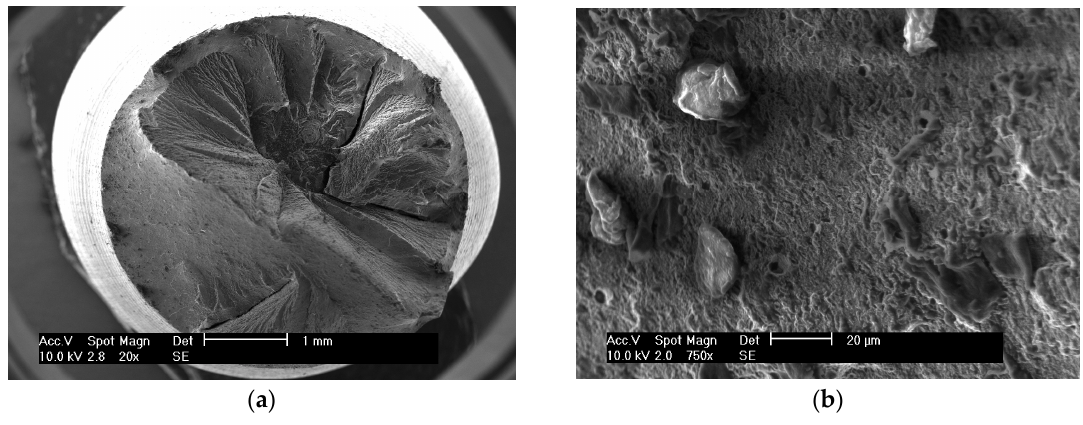
Figure 3. Tensile fracture surfaces obtained by SEM: ( a ) low magnification; ( b ) high magnification.